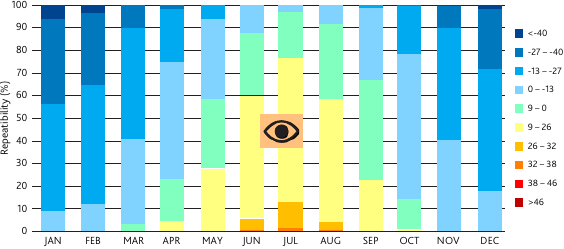
Figure 2. The repeatability of various UTCI gradations in Arkhangelsk-city (Period from 1966 to 2015). Based on data from